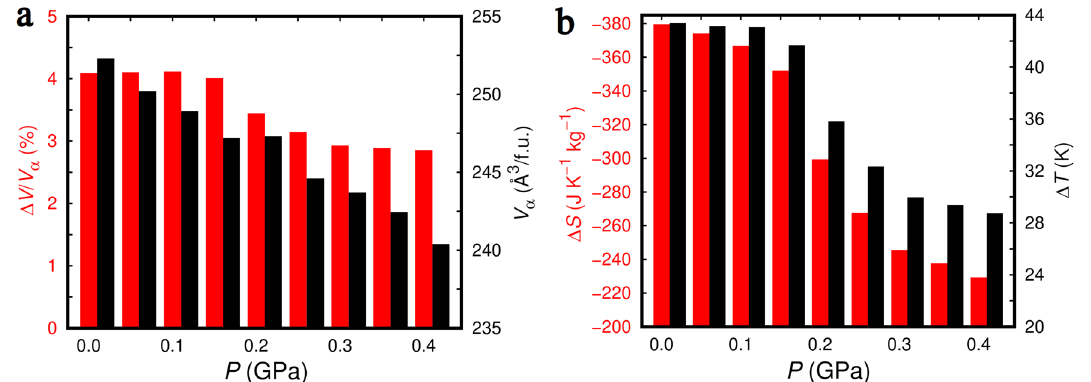
Figure 3. Effect of pressure on the structural and barocaloric properties of Li 2 B 12 H 12 estimated with classical molecular dynamics techniques and the force field reported in work 38 . ( a ) Relative volume change associated with the T -induced α → β phase transition expressed as a function of pressure (red); volume of the α phase per formula unit (f.u.), V α , at the phase-transition conditions (black). ( b ) Isothermal entropy (red) and adiabatic temperature (black) changes associated with the barocaloric response of bulk Li 2 B 12 H 12 expressed as a function of